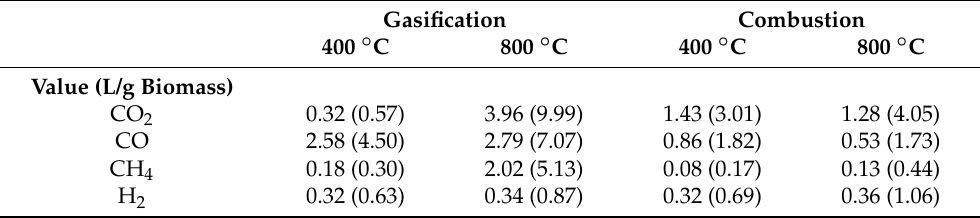
Table 3. Normalized gas emissions considering the different regimes of thermochemical conversion, temperatures, and the duration of the experiment (600 s). The numbers in brackets refer to the average percentage during the